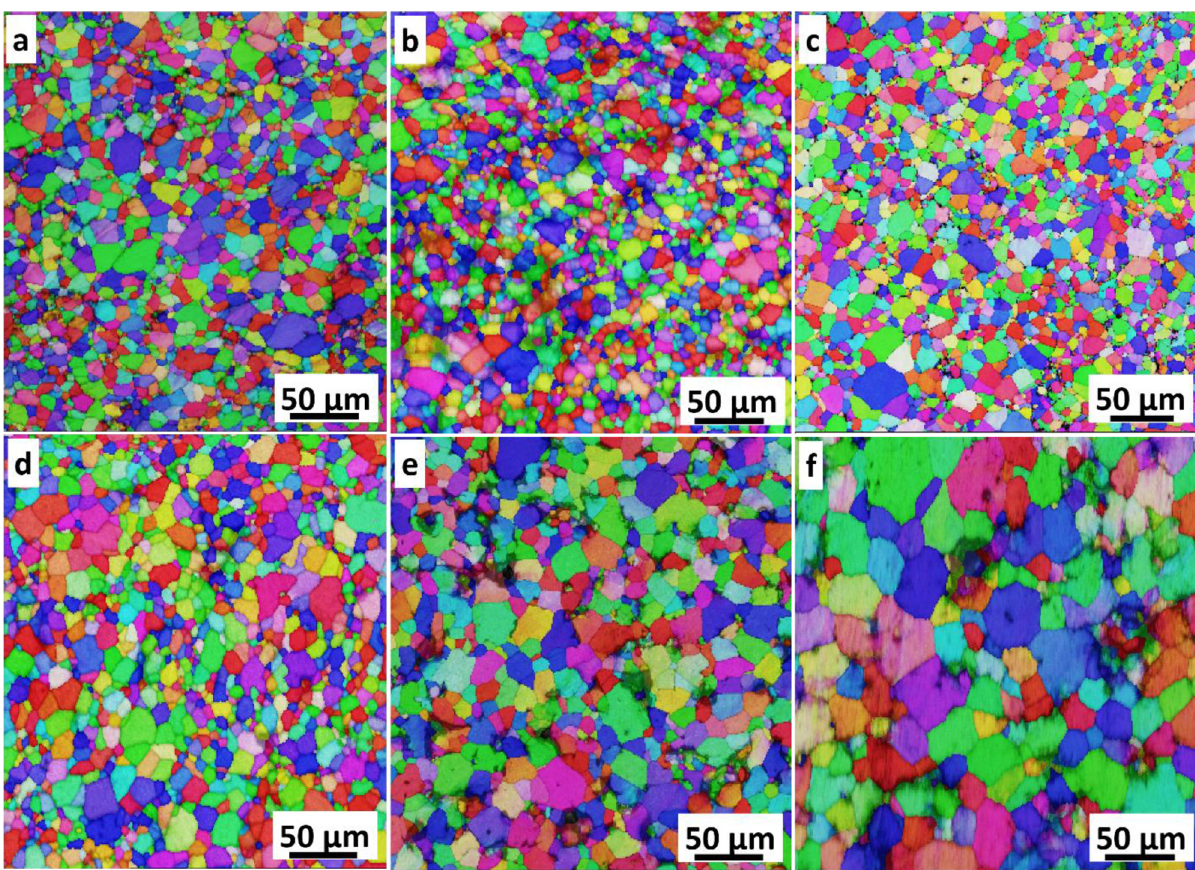
Fig. 4. Illustration of the grain boundaries of the sintered samples (a – c) NiAl, and (d – f) NiAl-CNT.